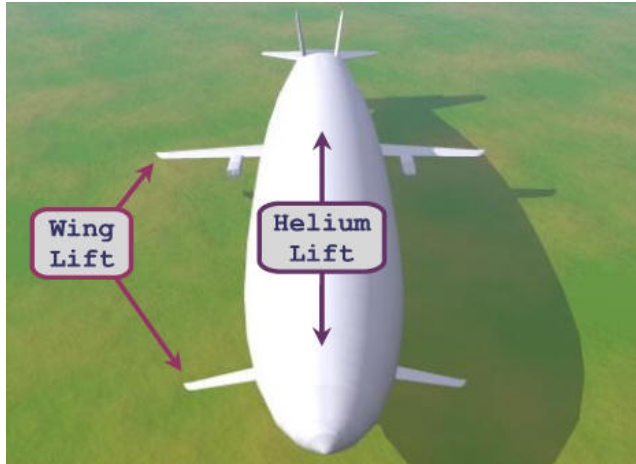
Figure 2. Dynalifter (Adapted from Ref. [39]).